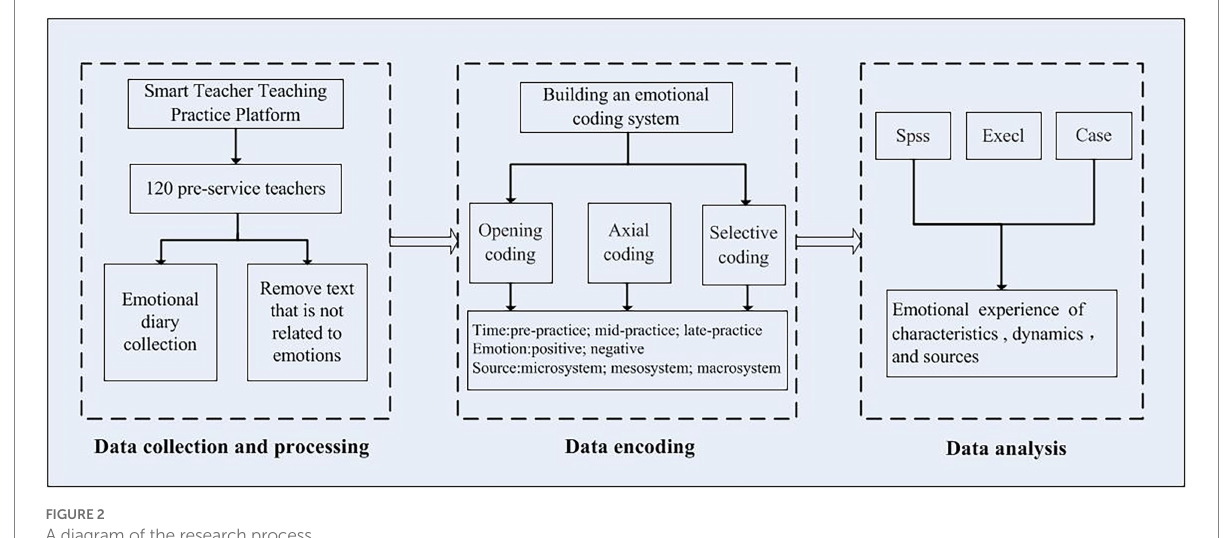
FIGURE 2 A diagram of the research